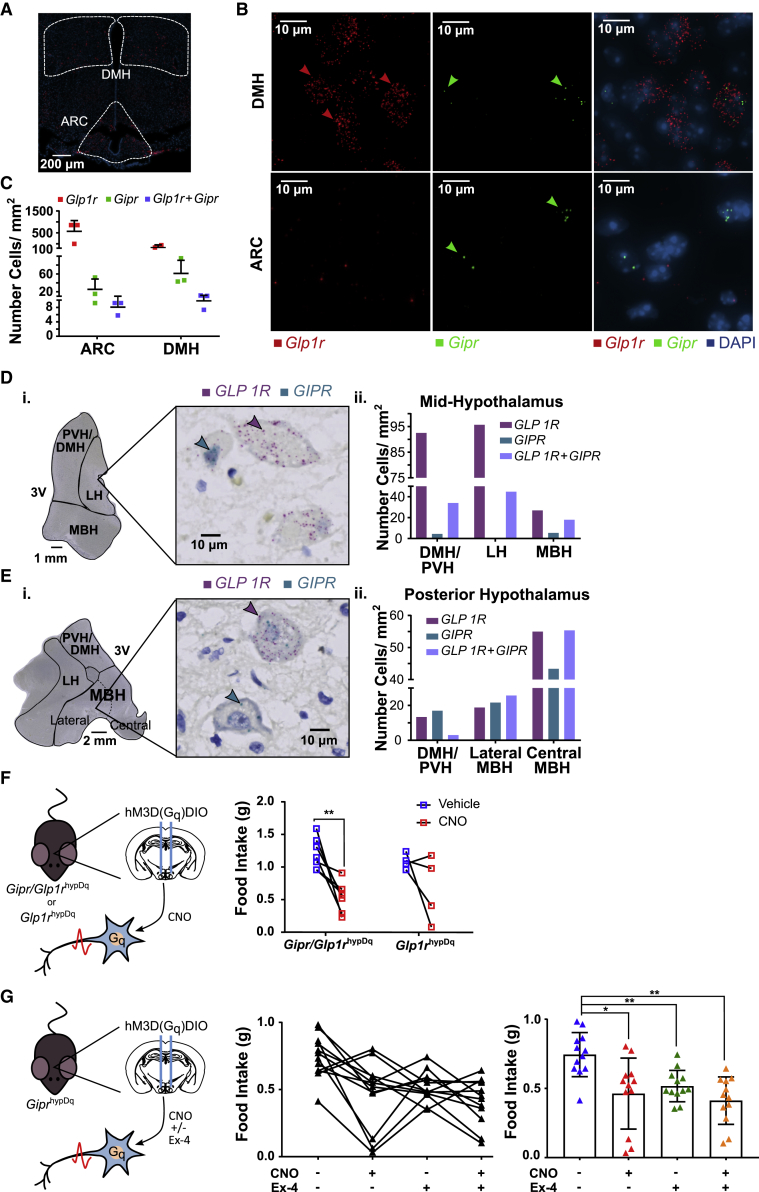
Partial Cellular Overlap of Gipr and Glp1r Expression, but Limited Effect of GLP1R-Co-activation on Gipr-Expressing Cell-Mediated Acute Anorexia(A–E) Coronal sections of mouse (A–C) and human (D–E) hypothalamus were co-labeled for Gipr or GIPR and Glp1r or GLP1R mRNA using RNAscope. Areas corresponding to the ARC and DMH in mouse and PVH/DMH, lateral hypothalamus (LH), and mediobasal hypothalamus (MBH) in human were assessed for Gipr or GIPR and Glp1r or GLP1R expression (B), (Di), and (Ei). Single- and double-labeled cells were counted and scored (C), (Dii), and (Eii.). Bars represent the mean ± SD (see also Figure S4).(F) Gipr-Cre x Glp1r-Cre and Glp1r-Cre-only mice were injected bilaterally with AAV-DIO-hM3D-mCherry into the hypothalamus to produce Gipr/Glp1rhypDq and Glp1rhypDq mice, respectively. CNO (1 mg/kg) or vehicle was injected i.p. following a 10-h daytime fast at the onset of the dark phase before measuring food intake 2 h post-activation (see also Figures S3C and S3D). Food intake was compared using a repeated measures 2-way ANOVA with a Sidak’s post-hoc test. ⁎⁎p < 0.01, Gipr/Glp1rhypDq n = 7, Glp1rhypDq n = 4.(G) Heterozygous Gipr-Cre mice were injected bilaterally with AAV-DIO-hM3D-mCherry into the hypothalamus to produce GiprhypDq mice. Following a 10-h daytime fast Exendin-4 (Ex-4) (1.5 nmol/kg) or saline was injected s.c. 1 h prior to the onset of the dark phase. CNO (0.3 mg/kg) or vehicle was injected i.p. at the onset of the dark phase, food was presented, and food intake measurements were taken 2 h post-activation (see also Figures S3E, S4C, and S4D). Bars represent mean ± SD. Food intake was compared using a repeated measures 2-way ANOVA with a Sidak’s post-hoc test. ⁎p < 0.05, ⁎⁎p < 0.01, GiprhypDq n = 12.